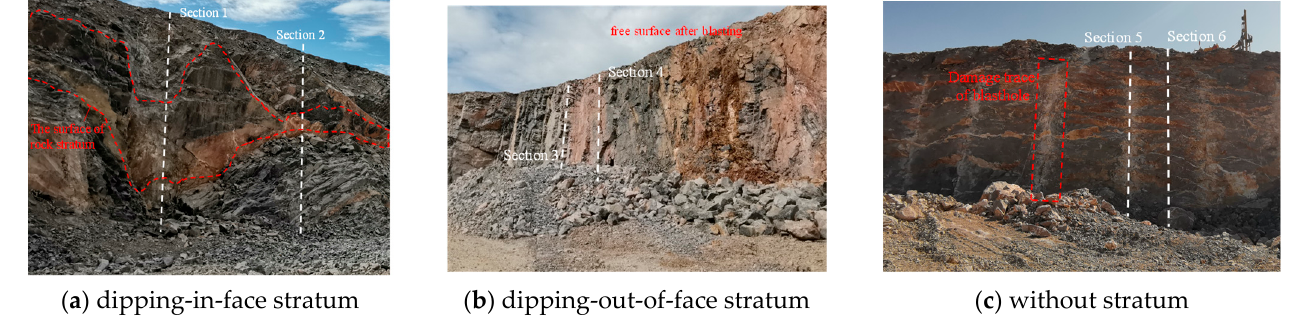
Figure 11. Failure patterns of the free face after blasting under different kinds of layered rock.